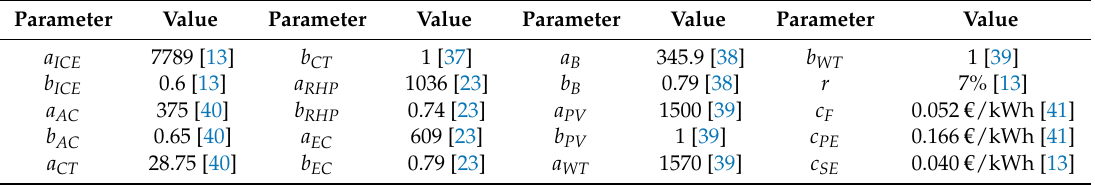
Table 2. Price of energy carriers and investment cost parameters (used in Equations (13)–(15)).